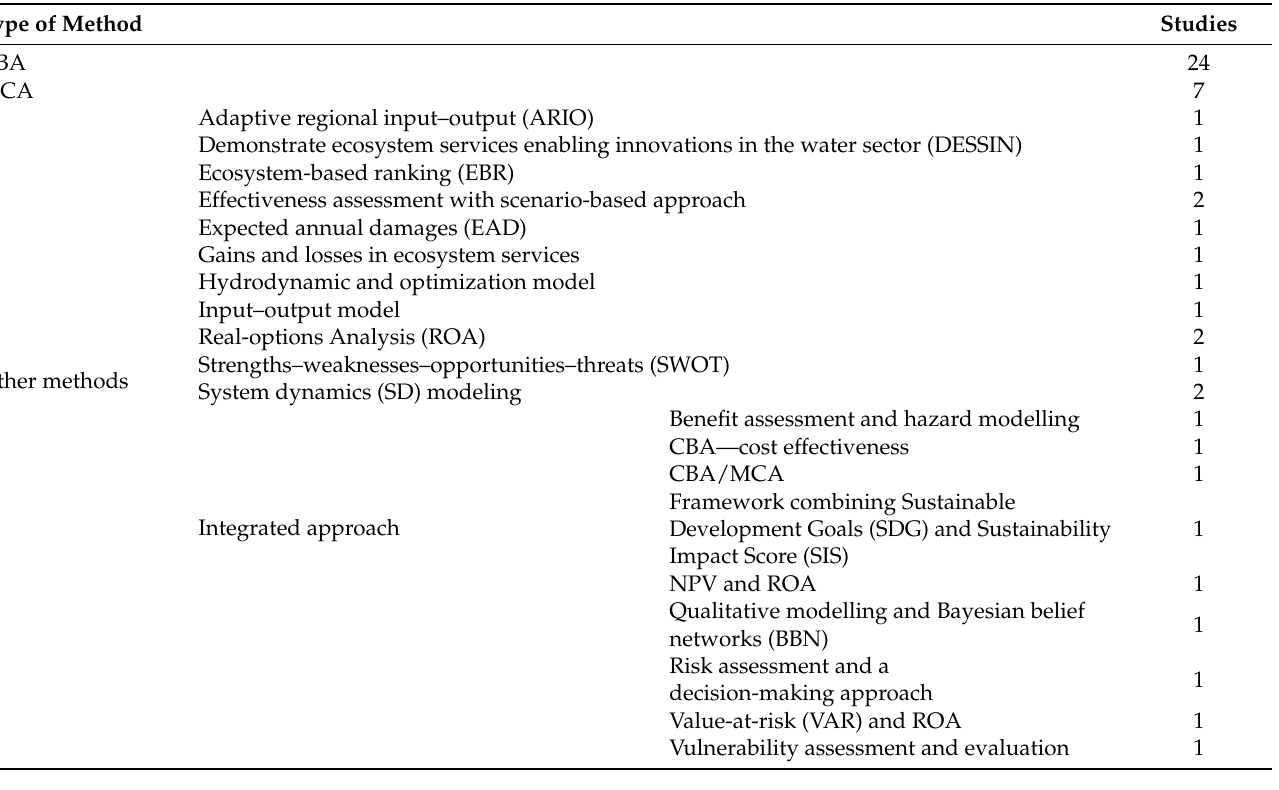
Table 3. Assessment methods applied in the reviewed